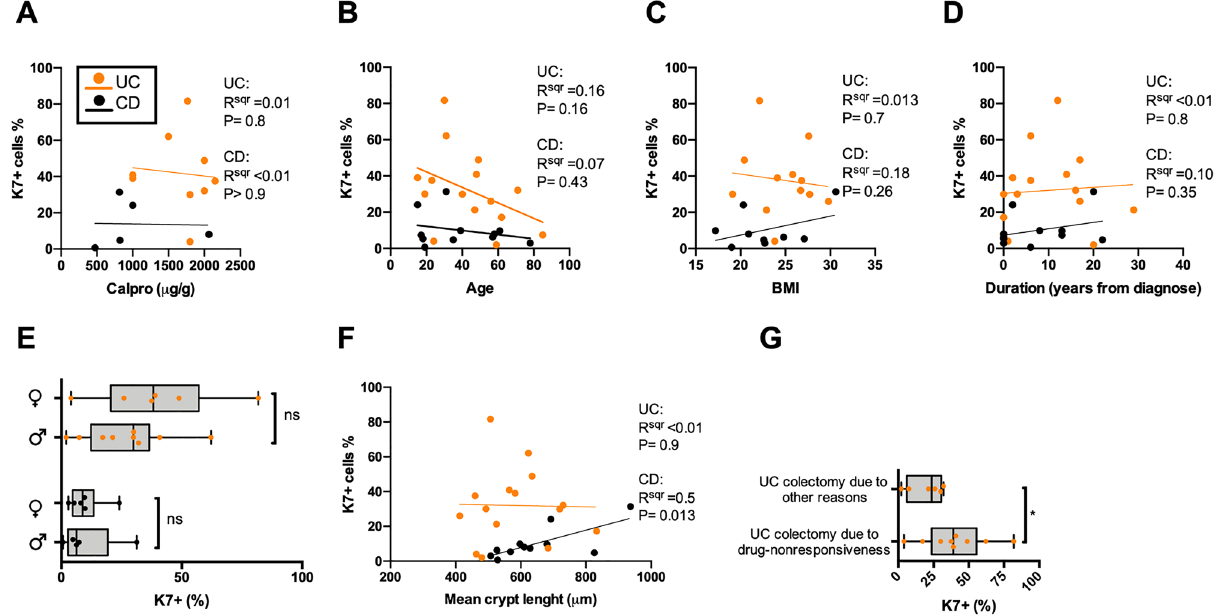
Figure 5. Correlation of clinical characteristics with K7 expression levels in IBD. ( A ) Fecal calprotectin (Calpro) levels prior to surgery had no correlation with colonic K7 levels, neither had ( B ) patient age, ( C ) BMI, ( D ) the duration of disease from onset to harvest nor ( E ) sex. ( F ) Mean top to bottom colon crypt length correlated with K7 in CD but not in UC. ( G ) K7 upregulation was the most pronounced in drug resistant UC patients. Orange dots in figures represent UC and black dots CD patients, illustrating the average percentage of K7+ cells in annotated areas. Samples presented here were derived from IBD patients in cohort A. Correlations of two variables were assessed using linear regression analysis. Mann–Whitney test was used in pairwise comparison. *P <